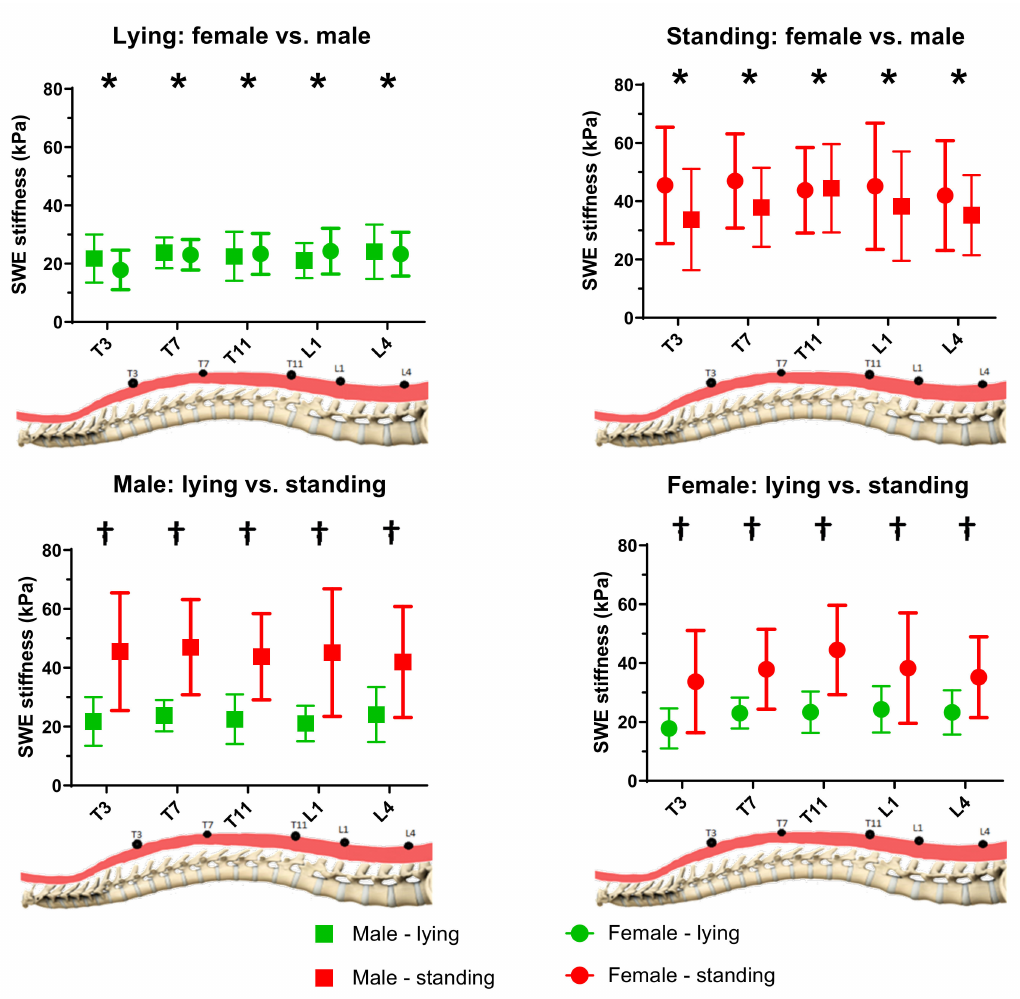
Figure 4. SWE sti ff ness at di ff erent levels of two genders in lying and standing postures ( n = 64). * Significant di ff erences existed in gender; † Significant di ff erences existed in